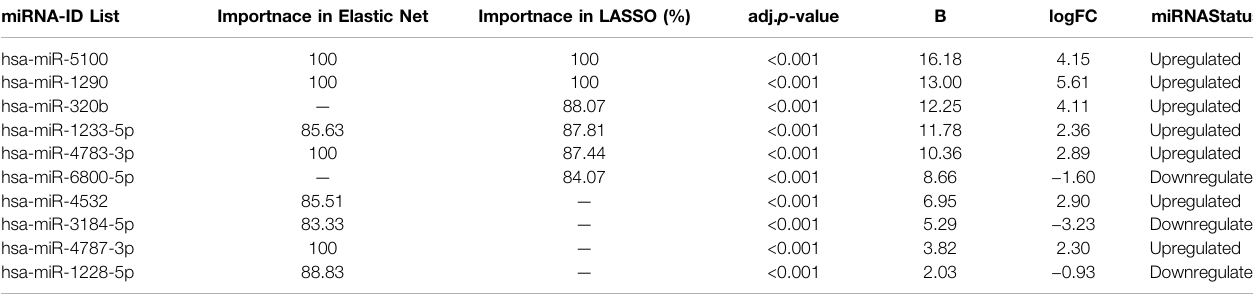
TABLE 2 | miRNAs identi fi ed with threshold over 80% importance in both Lasso and Elastic net in the dataset GSE106817 with miRNA status. miRNA-ID